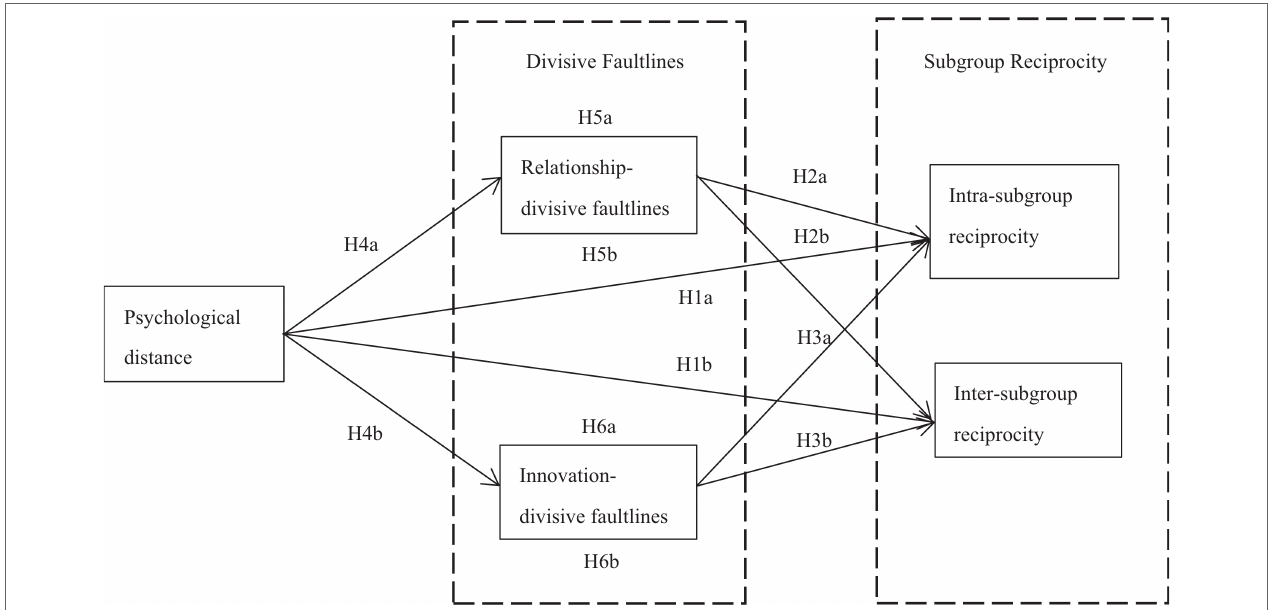
FIGURE 1 | The theoretical